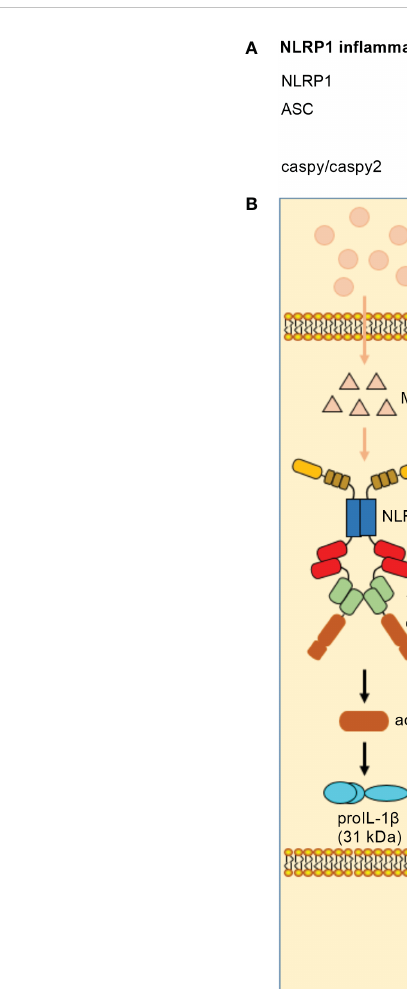
contains an N-terminal PYD, a central NACHT and a series of LRRs. Besides the three domains, piscine NLRP3 still contains a C- terminal B30.2 (PRY/SPRY) domain that is unique in fi sh (18, 20). However, the B30.2 domain is not functional in the assembly of NLRP3 in fl ammasome and the activation of caspy/caspy2. Cyprinid-type NLRP3 in fl ammasome consists of NLRP3, ASC and caspy/caspy2 (Figure 2A) or of NLRP3 and caspy2 (Figure 2B). In other fi sh species except Cyprinidae, NLRP3 in fl ammasome consists of NLRP3, ASC and pro-caspase-1 (Figure 2C). Upon ligand recognition, the PYD of NLRP3 interacts with the PYD of ASC. Then, the recruitment and activation of caspase-1 lead to the ASC-dependent IL-1 b maturation and GSDME-mediated pyroptosis. Cyprinid-type NLRP3 also directly activates caspy2 and elicits cell pyroptosis in a GSDME-dependent but ASC-independent manner (18). LPS and cellular oxidation were found to contribute to the activation of zebra fi sh NLRP3 in fl ammasome. The knockdown of zebra fi sh NLRP3 increased the mortality of embryos with E. tarda